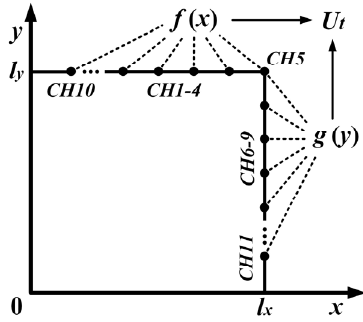
Figure 10. Fitted wall temperature curves based on measurement data.